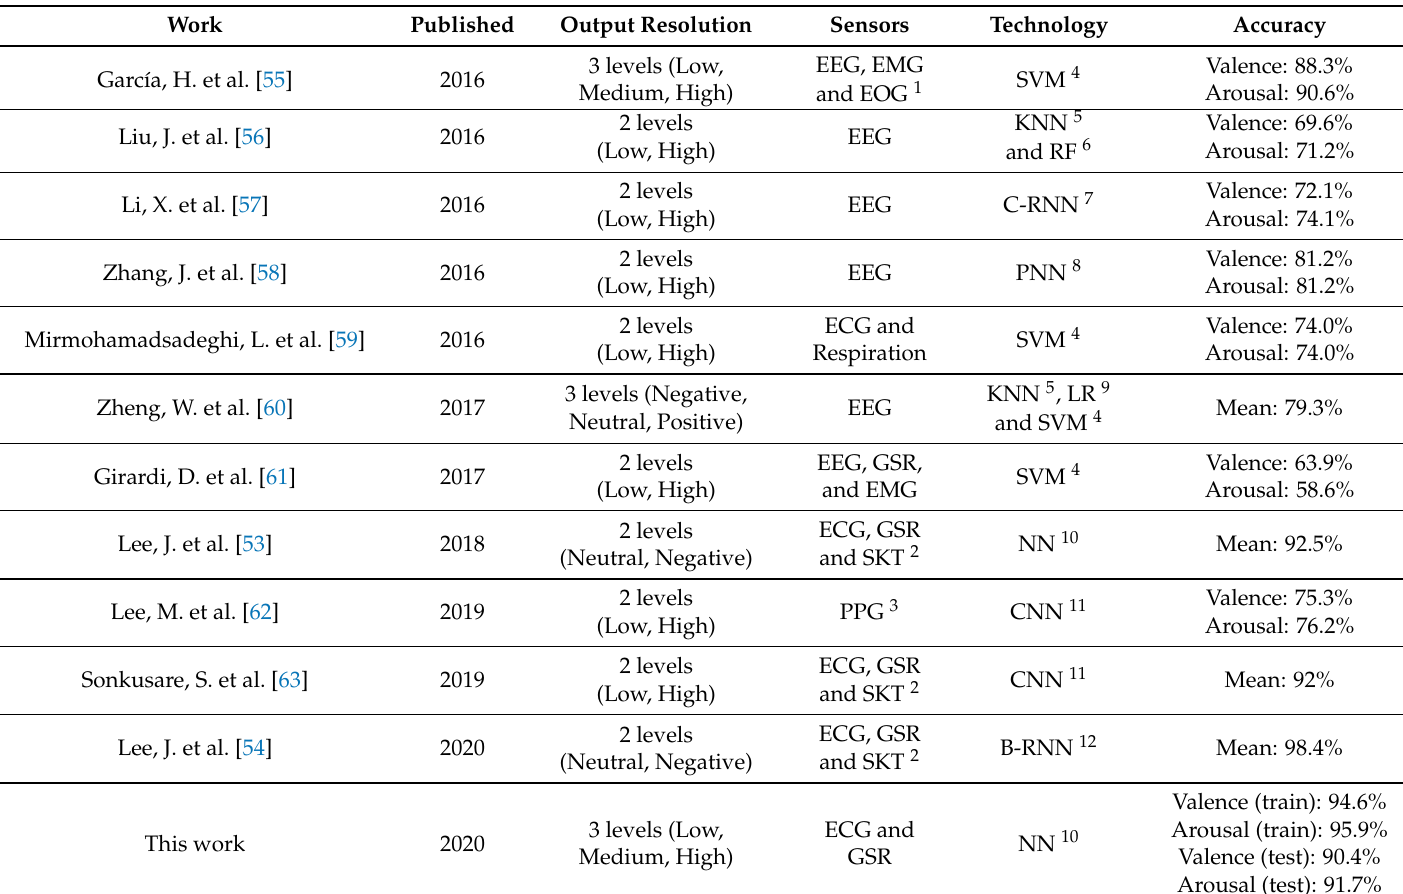
Table 14. Results comparison with previous